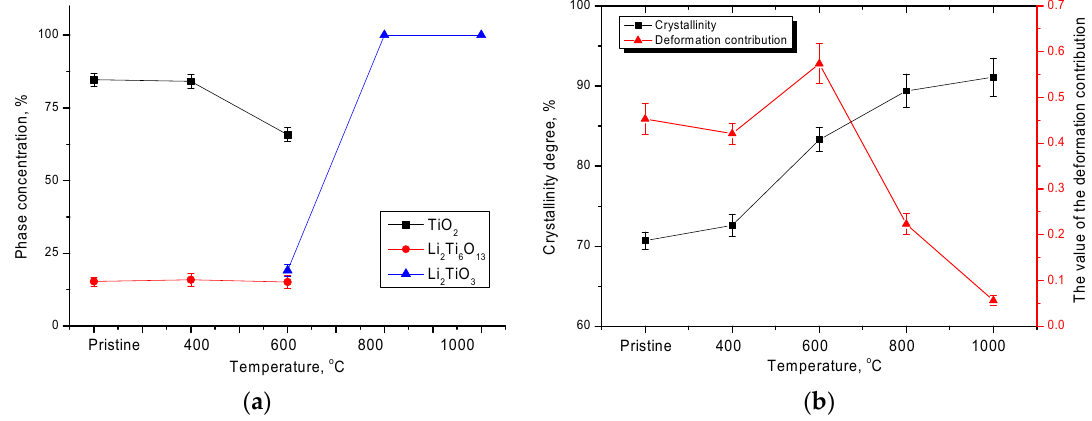
Figure 3. ( a ) Diagram of ceramic phase composition depending on annealing temperature; ( b ) graph of changes in the crystallinity degree and deformation contributions to the change in the shape of diffraction reflections.